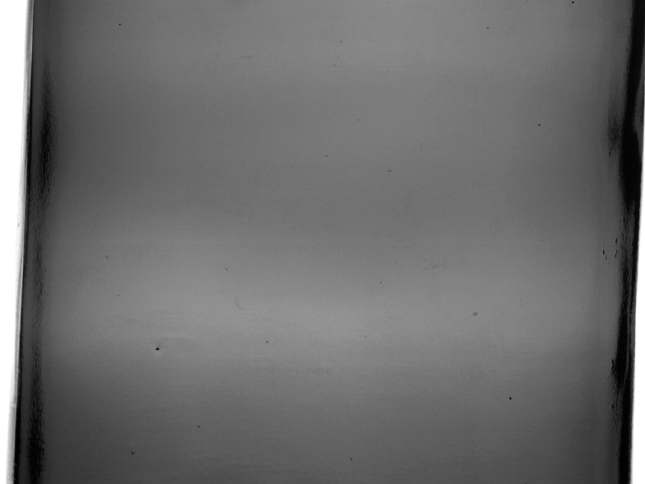
Figure 4. Image of a bottle grabbed by the camera.